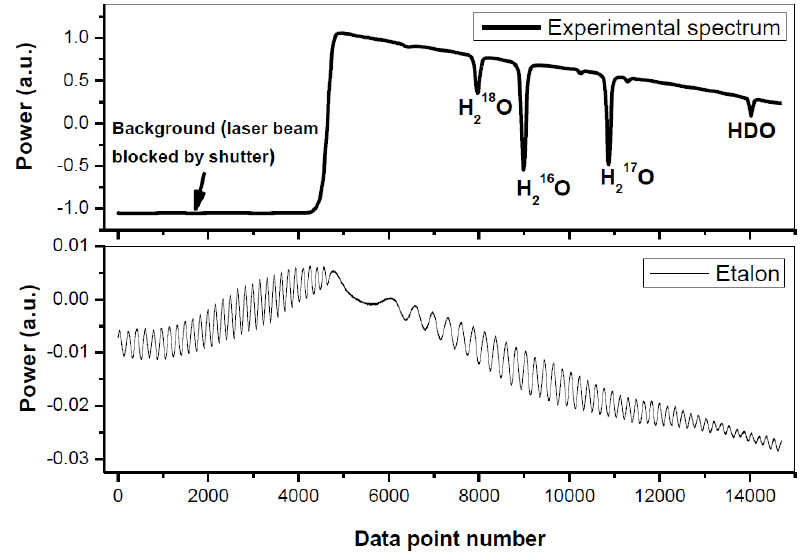
Figure 2. Experimental spectrum of H O isotopologues around 2.73 µm. At the bottom is 2 shown the fringe from an etalon that was used for frequency metrology in combination with the H O line positions provided by the HITRAN 2